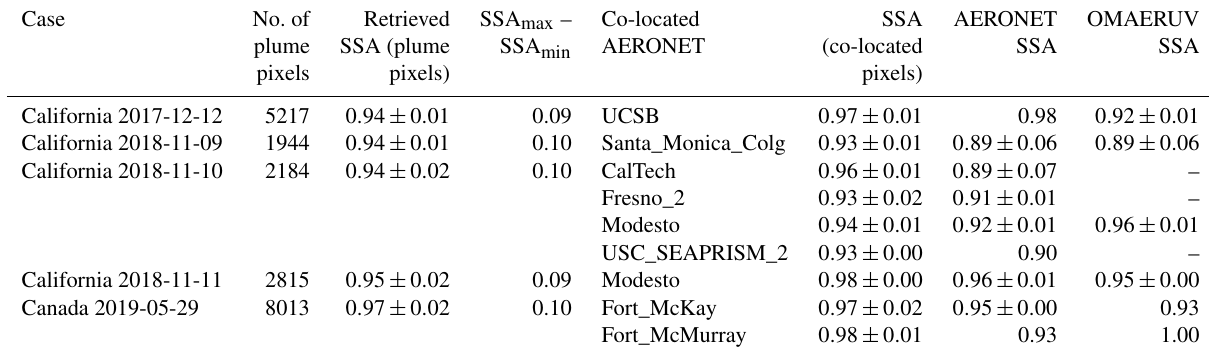
Table 4. SVR-retrieved SSA. If no standard deviation is given, it indicates that only one record was available. Case No. of Retrieved SSA max – Co-located SSA AERONET OMAERUV plume SSA (plume SSA min AERONET (co-located SSA SSA pixels pixels) pixels)